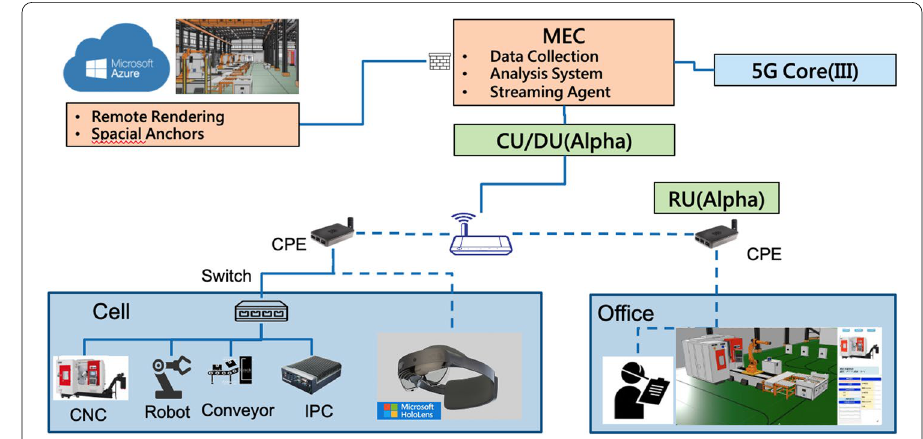
Fig. 3 Implementation of AR/VR for process